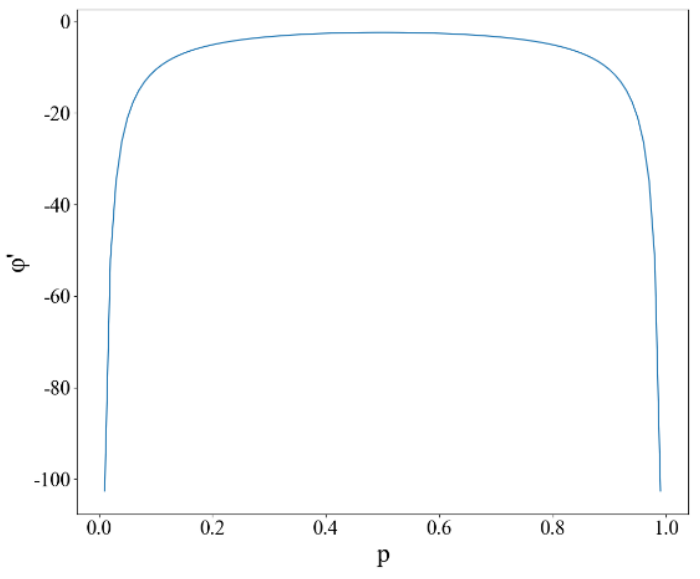
Figure 4. First derivative image of VTE.